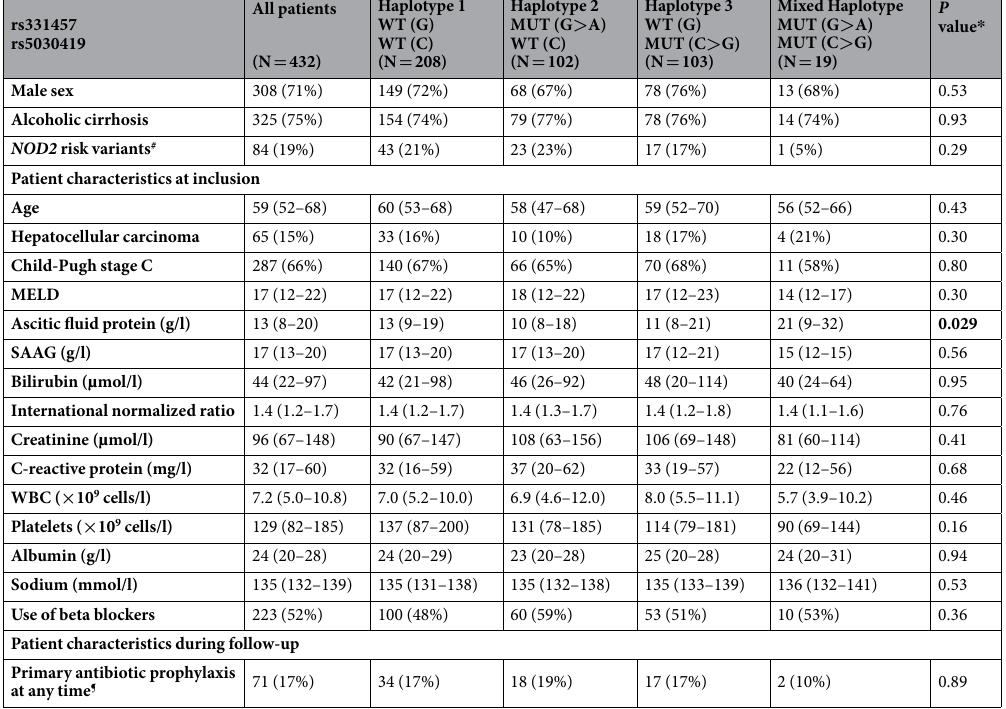
Table 1. Patients’ characteristics stratified by the TRAF6 haplotype. Median/IQR or Frequency/Percentage are shown. * P values from from Kruskal Wallis test or Fisher’s exact test as appropriate. # Nucleotide-binding oligomerization domain-containing protein 2 risk variants R702W, G908R and L1007fs. ¶ Comprising quinolones, cotrimoxazole and rifaximin. Data available from 421 patients (97.5%). Abbreviations: mutation (MUT); wild-type (WT); model for end-stage liver disease (MELD); Serum ascites albumin gradient (SAAG); White blood cell count (WBC); spontaneous bacterial peritonitis